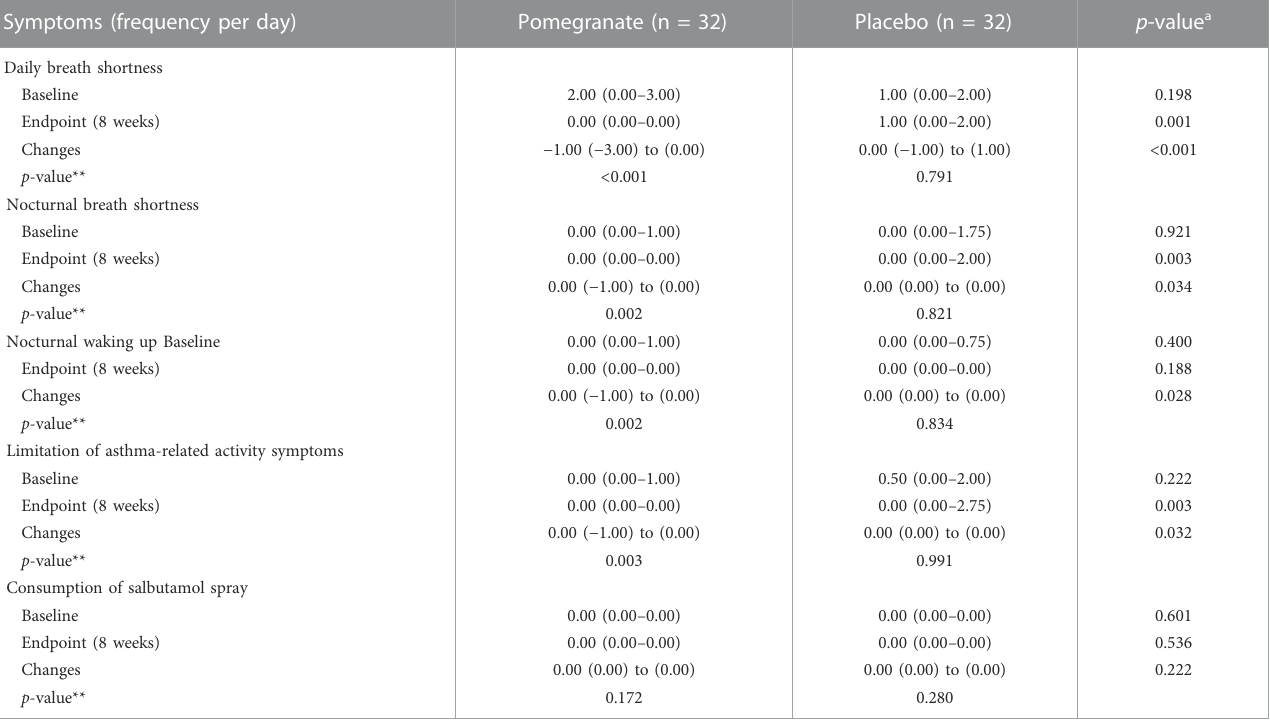
TABLE 4 Comparing clinical changes between the intervention and control groups. Symptoms (frequency per